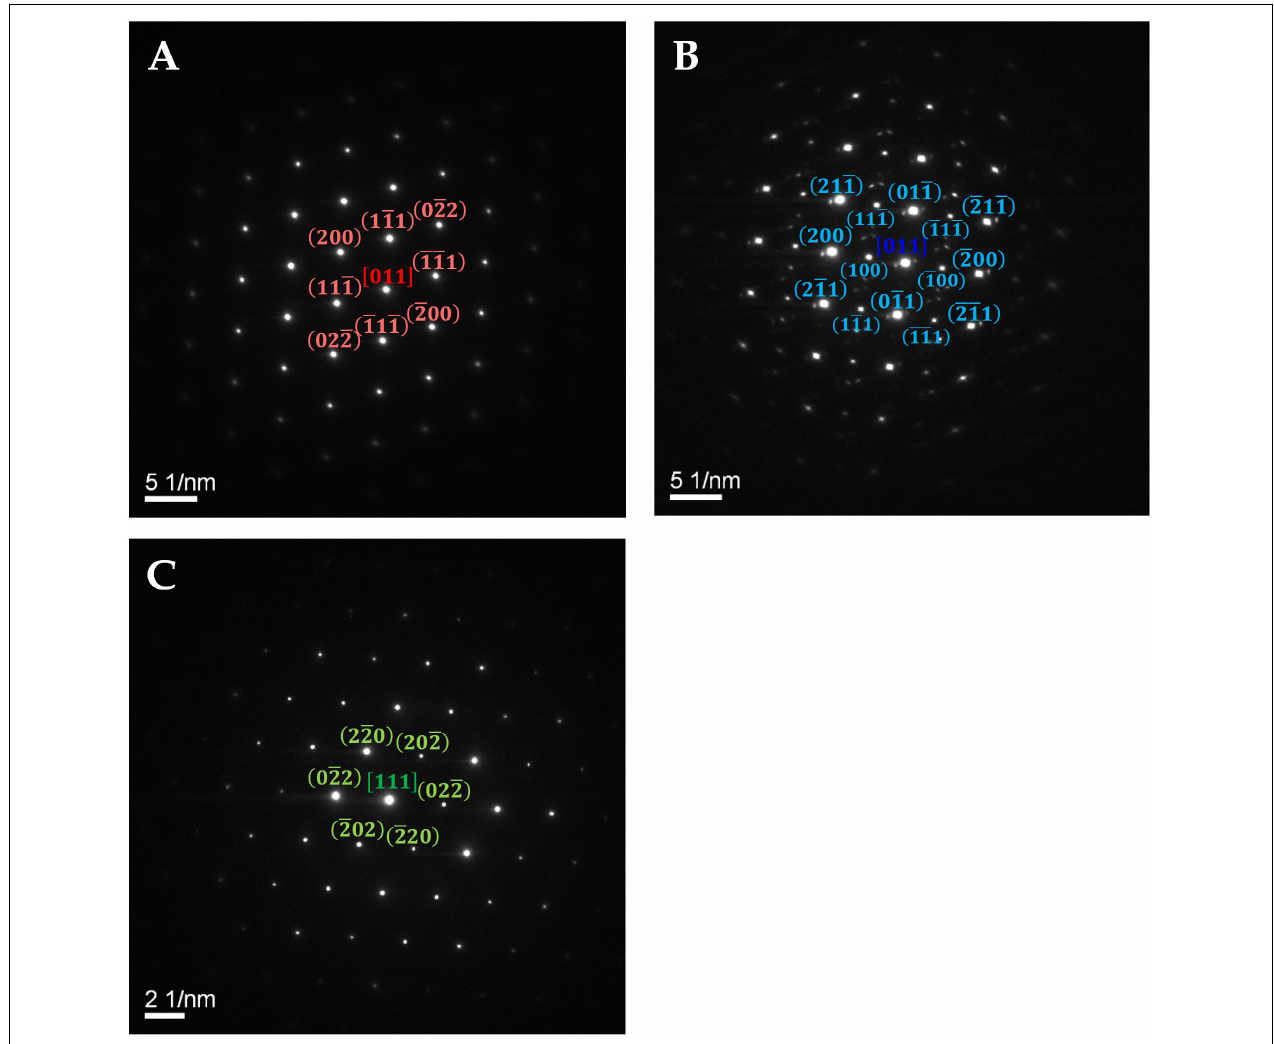
FIGURE 7 | SAED patterns in the homogenized AlCrFe 2 Ni 2 alloy – obtained from (A) the FCC phase in Z.A. < 011 > (B) the B2 phase in Z.A. < 011 > ; (C) the FCC M 23 C 6 phase in Z.A. < 111 >